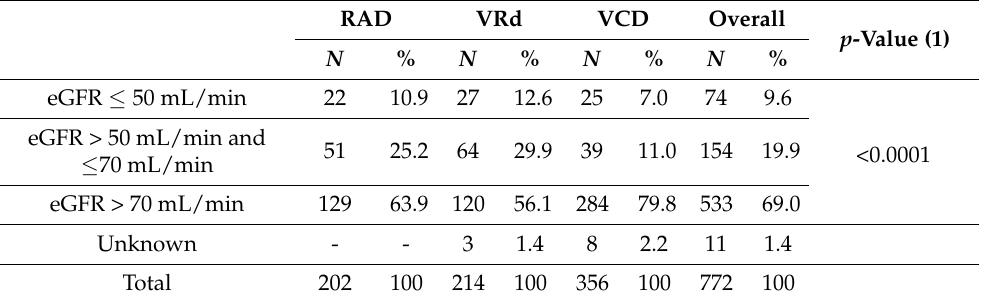
Table 2. Renal recovery in patients undergoing induction therapy. Estimated glomerular filtration rate at screening in categories. Population: per-protocol set, N =